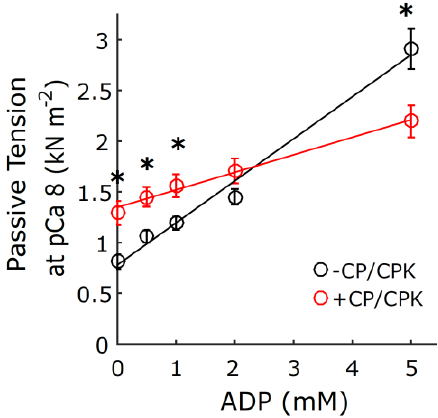
Figure 4. Tension increased with increased [ADP] under low [Ca 2+ ] (pCa 8.0) relaxing conditions. Steady-state isometric stress (= force per cross-sectional area) was plotted against [ADP] in the presence and absence of CP and CPK. Nested two-way linear mixed models analysis showed main effects of ADP ( p < 0.001), CP/CPK ( p = 0.03), and an ADP*CP/CPK interaction ( p < 0.001), with * indicating a Fisher’s LSD difference between − CP/CPK and +CP/CPK at a single [ADP] at p < 0.05. n fibers was 10 for each group, from two hearts.